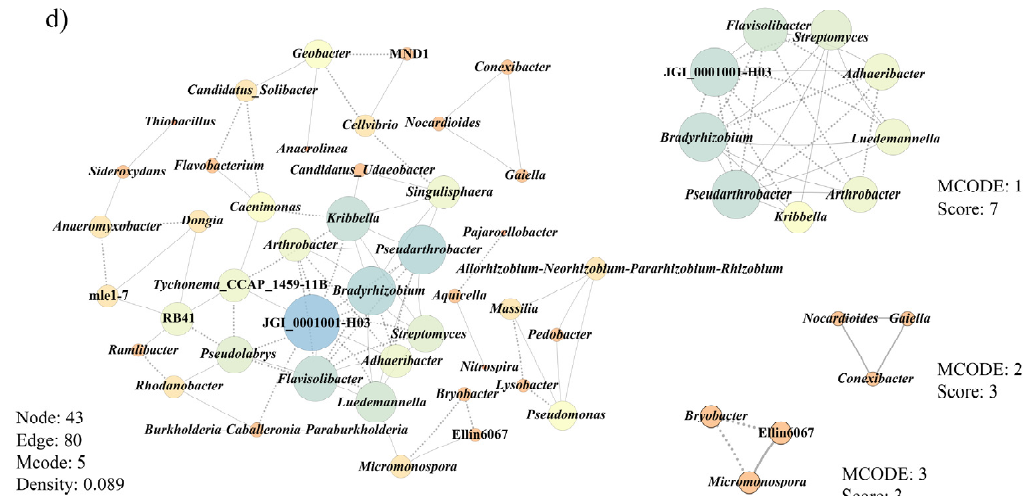
Figure 7. Microbial co-occurrence network in MCS associated with the high-yield group ( a , b ) and low- or no-yield group ( c , d ). The solid line represented positive co-occurrence and the dotted line indicated negative co-occurrences. Node size indicates the number of taxa connected to it (node size represents the degree of each taxonomy), the size from small to big represents the degree from low to high.